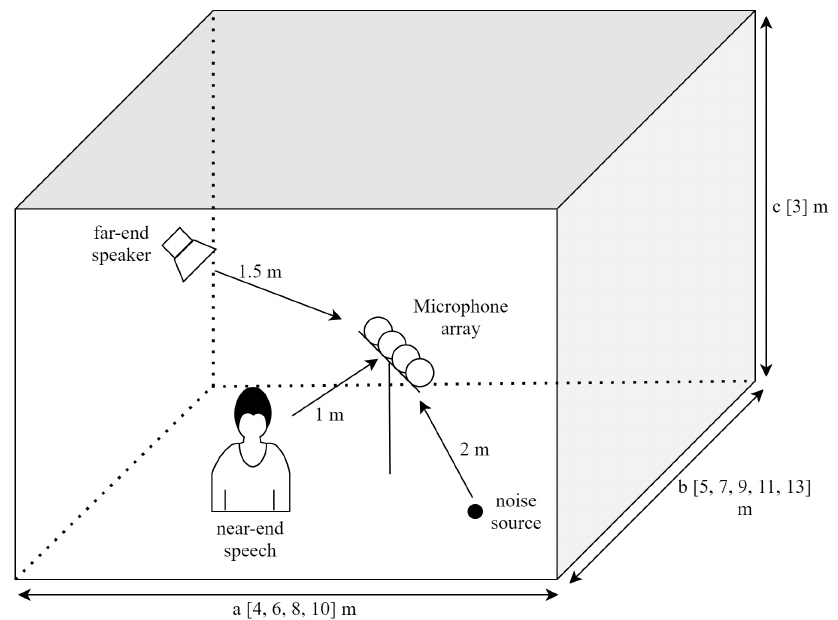
Figure 6. Simulation